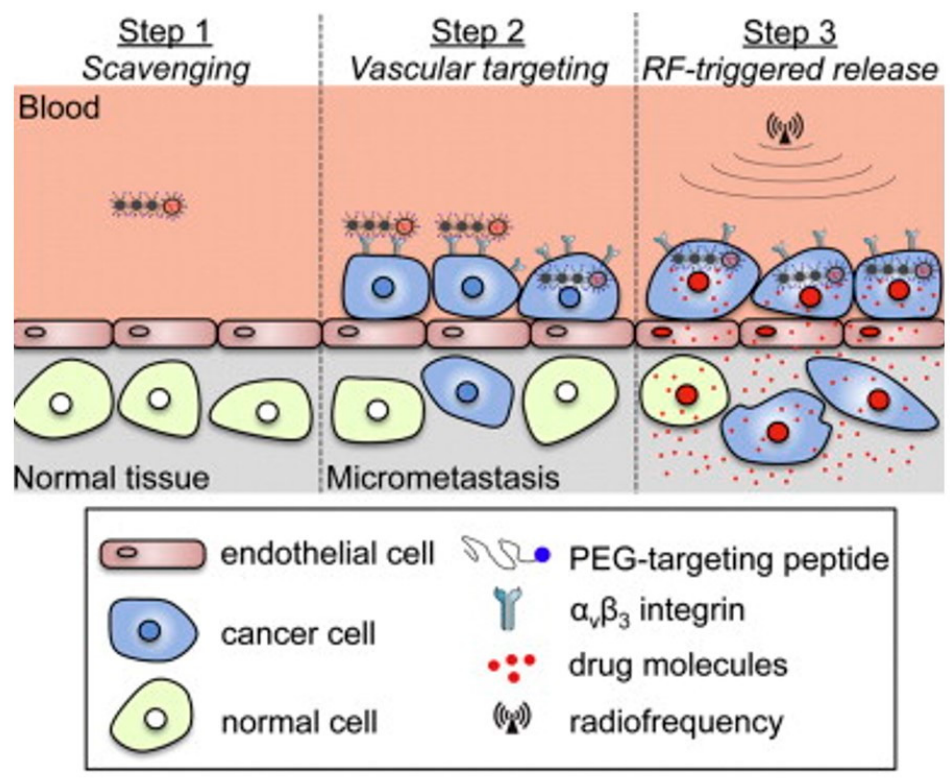
Figure 13. Schematic presentation of therapeutic anticancer approach based on nanochains following three steps. (1) Short nanochain loaded with drug circulates in the blood. (2) Nanochains’ target micrometastases. (3) Radiofrequency-triggered drug release from the nanochains. Reproduced from [110] Copyright 2013, with permission from Elsevier.